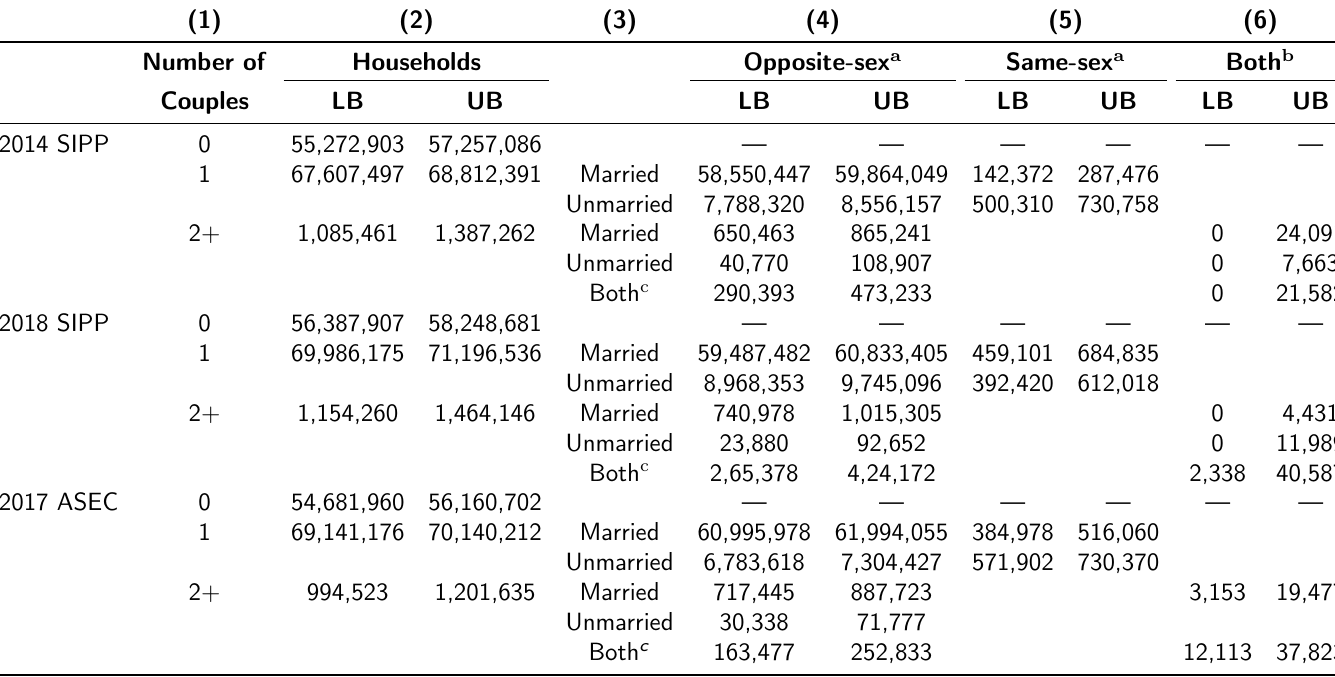
Table A.1: Estimated lower and upper bounds at 95% confidence level for counts in Table 1